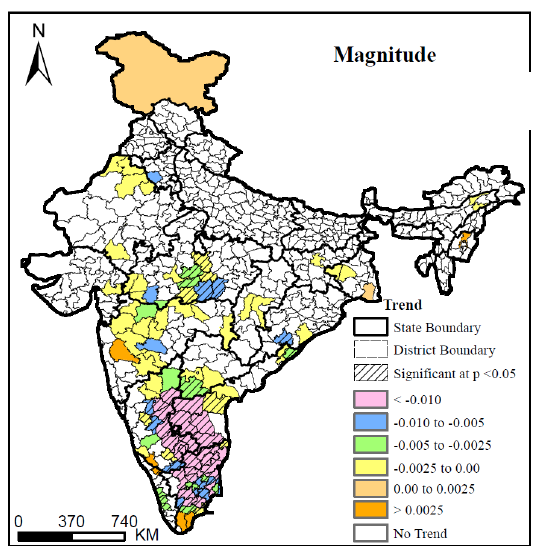
Figure 13 Trends of meteorological drought magnitude during 1982-